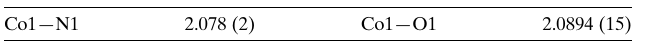
Table 2 Selected bond lengths (A˚ ) for 2 .